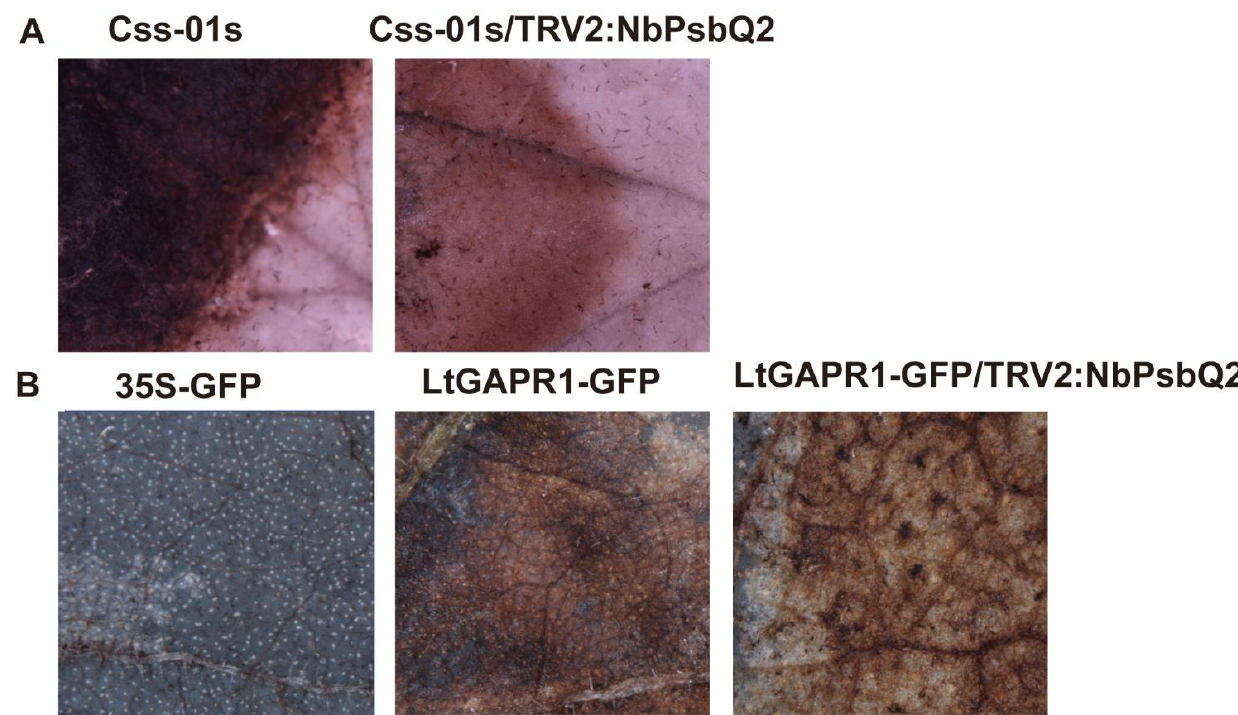
Figure 5. ROS production in NtPsbQ2-silenced plants. ( A ) WT and NbPsbQ2-silenced N. benthamiana were inoculated with L. theobromae mycelial plugs (5 mm in diameter) and then kept in a chamber under constant humidity and temperature for 24 h before DAB staining. ( B ) ROS production detection in transiently expressing GFP leaves, transiently expressing LtGAPR1-GFP leaves, or NbPsbQ2-silenced leaves and LtGAPR1-GFP-expressing leaves, as shown by the DAB test.